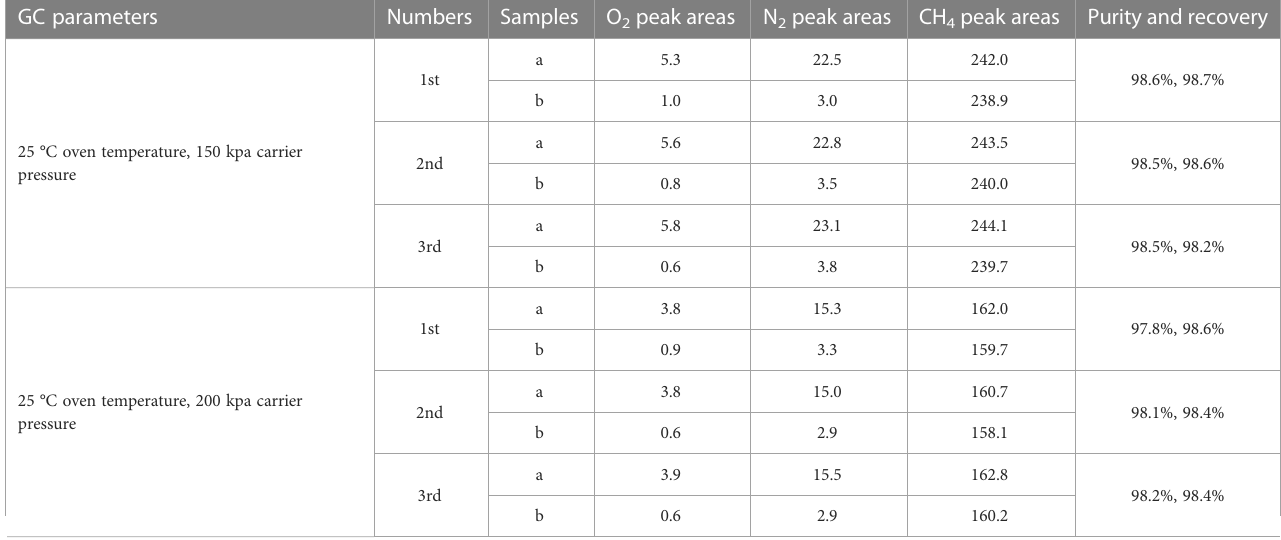
TABLE 4 Comparison of methane puri fi cation results under different conditions of chromatography. GC